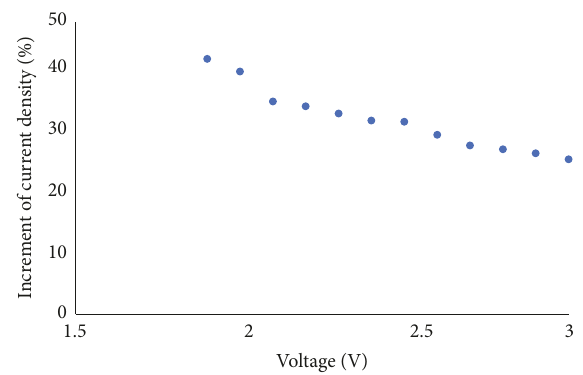
Figure 5: Increment of the current density as a function of the difference applied